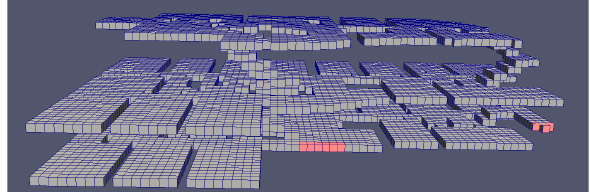
Figure 10. Surface skeleton, subsampled to 41cm resolution, to be used as a navigation grid. Red voxels indicate main and emergency